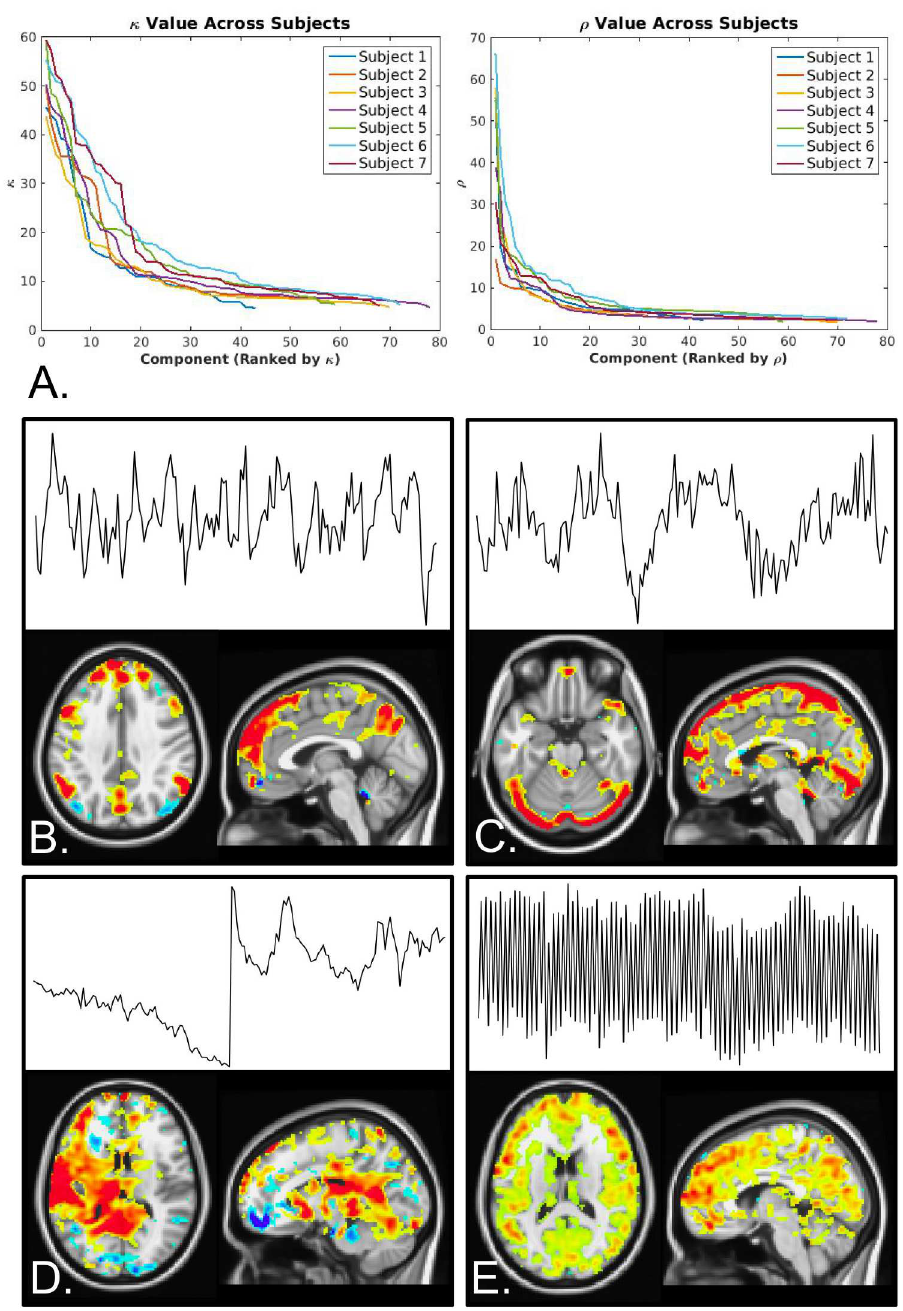
Fig 4. MEICA performance. A. Curves of κ and ρ for all subjects. Both curves display the characteristic “L” shapeexpectedfrom the ME-ICA algorithm. κ describesthe goodness of fit to the TE dependence of each componentand ρ describedthe fit to a Δ S 0 model. In general,components with κ above and ρ belowthe elboware kept in the denoised timeseries. B-E displayexamplenetworks from one representative subject. B. An exampleacceptedBOLD component (DMN). C. A rejected componentclassified as an R2 * artifact. D. A rejectednon-BOLDcomponent.E. A rejectedPW